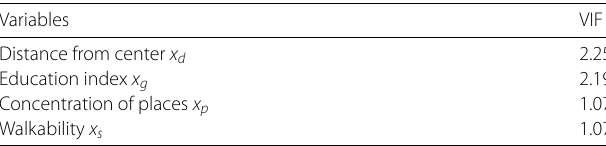
Table 2 Variance Inflation